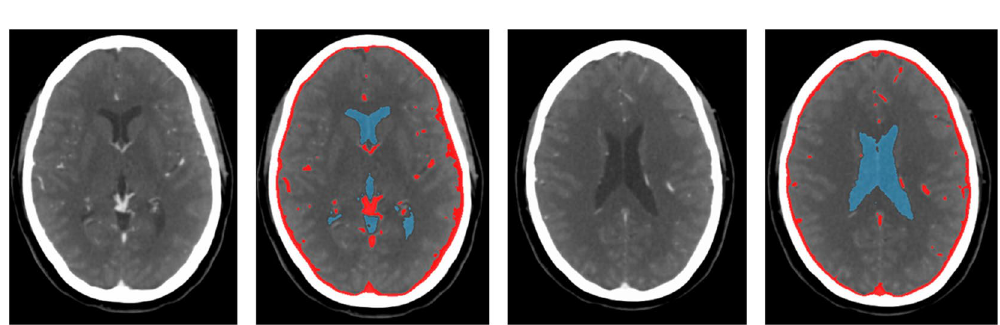
Figure 5. The result of intracranial segmentation after atlas registration (first panel) and refined segmentation after levelset evolution (second panel). Corresponding volume renderings (axial view from the skull base, coronal and sagittal view).